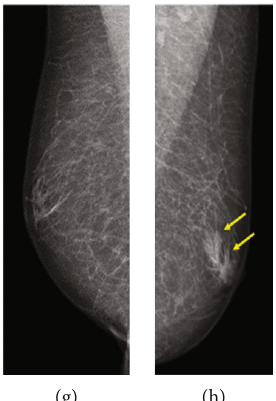
Figure 4: Normal bilateral mammograms and bilateral mammograms showing left breast gynecomastia. (a) RCC, (b) LCC, (c) RMLO, and (d) LMLO views, respectively. There are no masses or parenchymal distortion and suspicious calci fi cations or skin thickening. (e) RCC, (f) LCC, (g) RMLO, and (h) LMLO views, respectively. Left breast mammogram shows dendritic subareolar density with posterior linear projections radiating into the surrounding tissue toward the upper-outer quadrant (yellow arrows), suggesting chronic dendritic gynecomastia (f, h). Right breast mammograms (e, g) appear